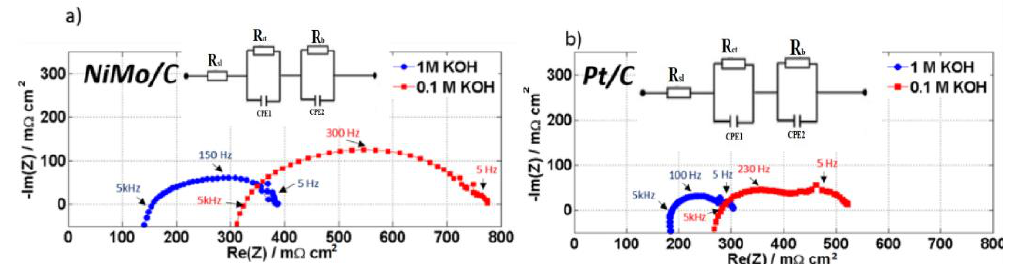
Figure 6. Electrochemical impedance is taken at 0.4 A in both 1 M and 0.1 M KOH at 50 °C. ( a ) A 5 mg cm − 2 NiMo loading compared to ( b ) a 1 mg cm − 2 Pt. Cell active area: 25 cm − 2 . Both catalyst coated membranes (CCMs) using 3 mg cm − 2 Ir-black. The impedance data represented by symbols and the fitted impedance data represented by a solid line.